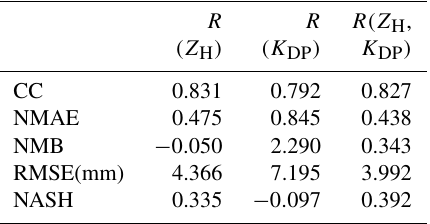
Table 5. Verification of the radar-based rainfall 24h accumulation products of Estonia. Z H is not corrected for attenuation.